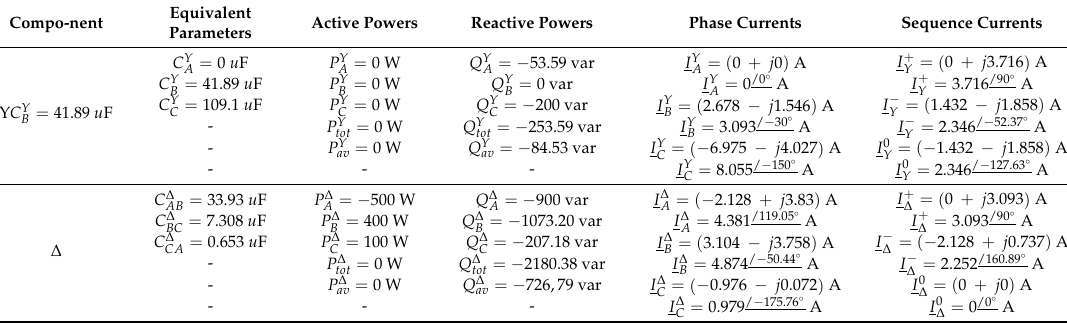
Table 3. The unbalanced compensator—resized (BCC).